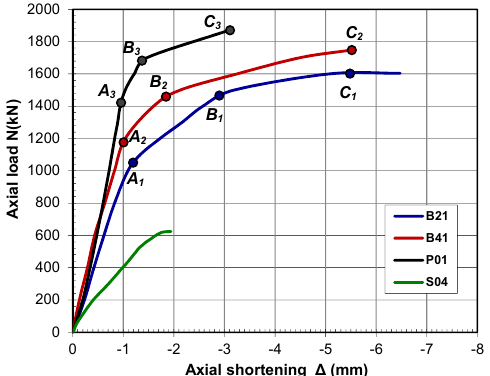
Figure 15. Comparative relationships of load versus deformation of specimens.